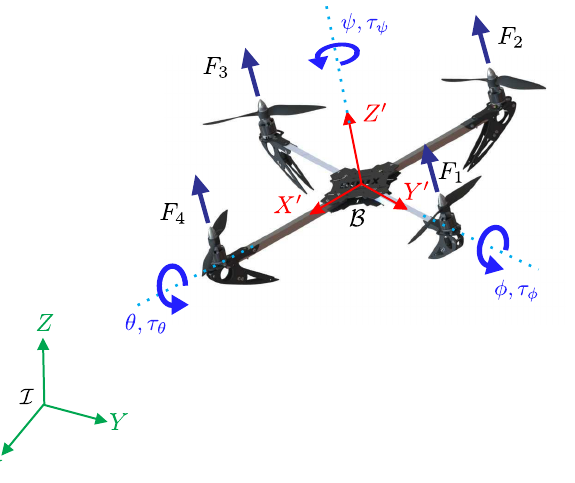
Figure 1. A flying quadrotor subjected to four main control